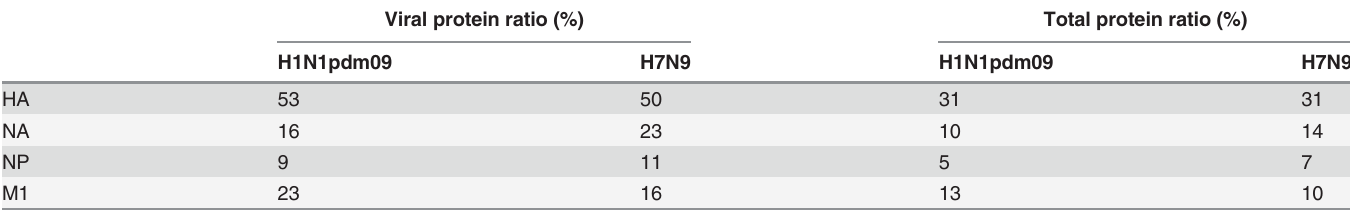
Table 1. % Viral and Total Protein ratios of H1N1pdm09 and H7N9 vaccinesa. Viral protein ratio